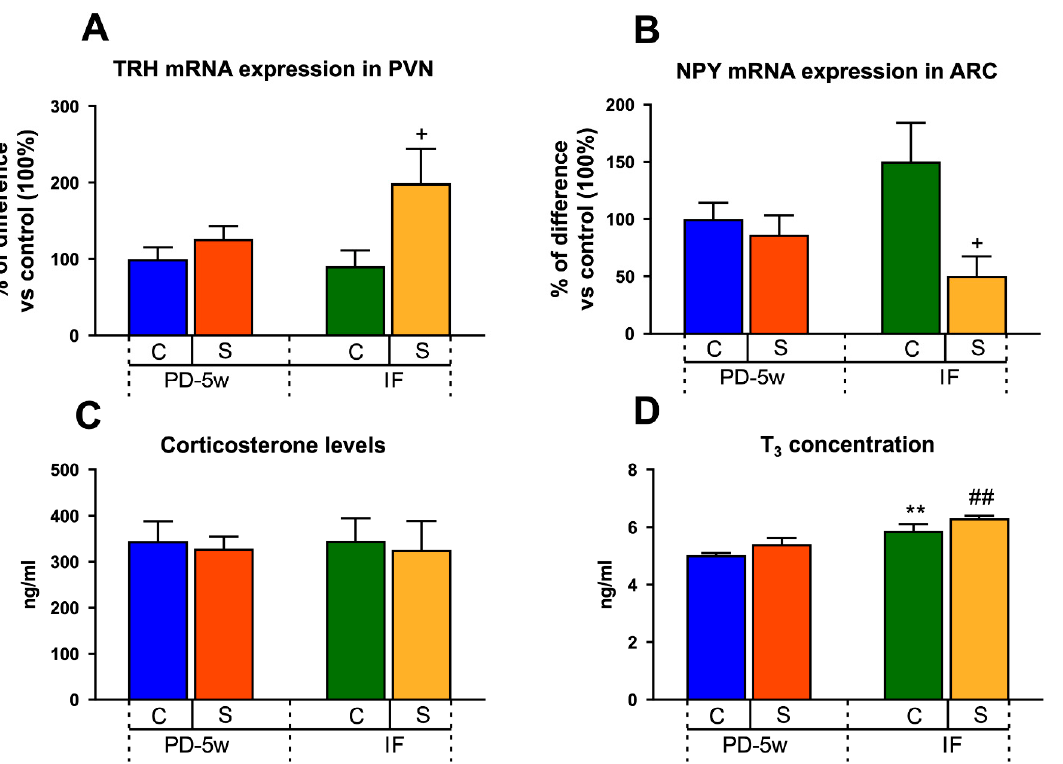
Figure 6. Effect of stress and intermittent fasting on neuroendocrine parameters. ( A ) TRH mRNA expression in the hypothalamic paraventricular nucleus (PVN) and ( B ) NPY mRNA expression in the hypothalamic arcuate nucleus (ARC) of the control or stressed animals fed with a PD and subjected to two feeding schedules: food available all day (with a cumulative intake time of 5 weeks, C-PD-5w, S-PD-5w) or intermittent fasting (C-IF, S-IF) for 3 additional weeks. Values are the mean ± SEM of the mRNA levels expressed in % of difference vs. C-PD-5w (n = 4 rats/group). ( C ) Corticosterone and ( D ) T 3 serum levels expressed as ng/mL. Data are the mean ± SEM (n = 4 rats/group). ** p < 0.01 vs. C-PD-5w; ## p < 0.01 vs. S-PD-5w; + p < 0.05 vs. C-IF.